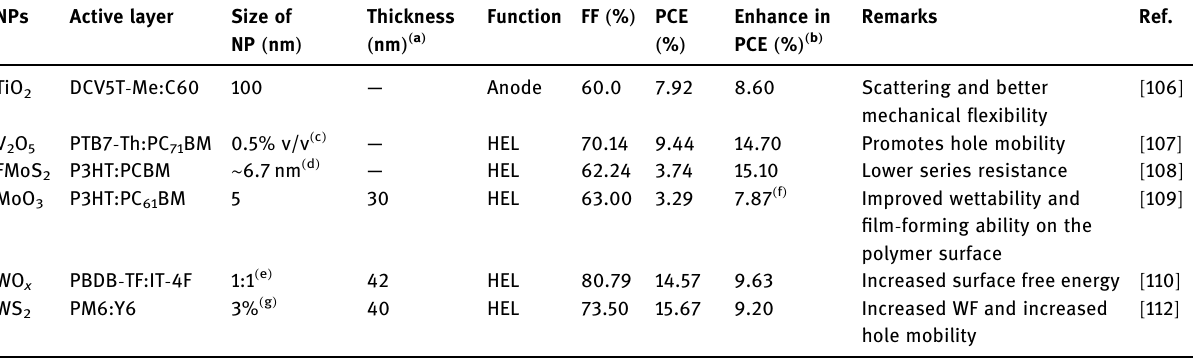
Table 7: Device characteristics of OPVs with inorganic NPs doped into PEDOT:PSS NPs Active